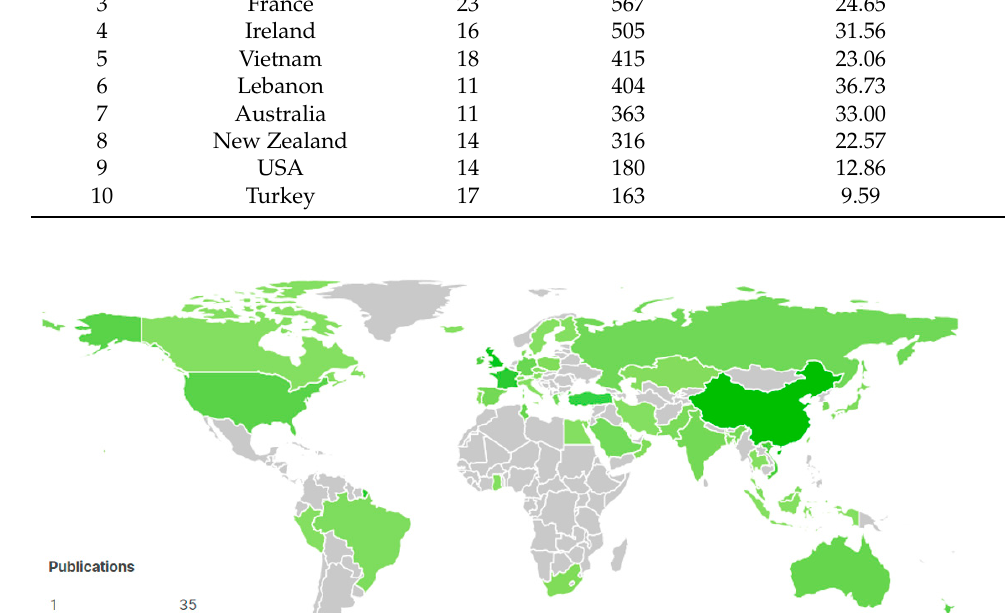
Figure 6. Publications by country world map.